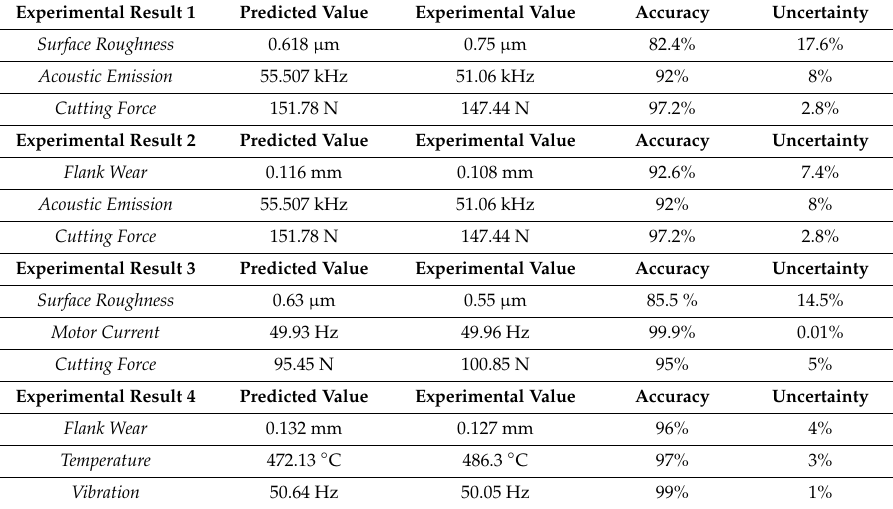
Table 9. Comparison of experimental and predicted results for sensor